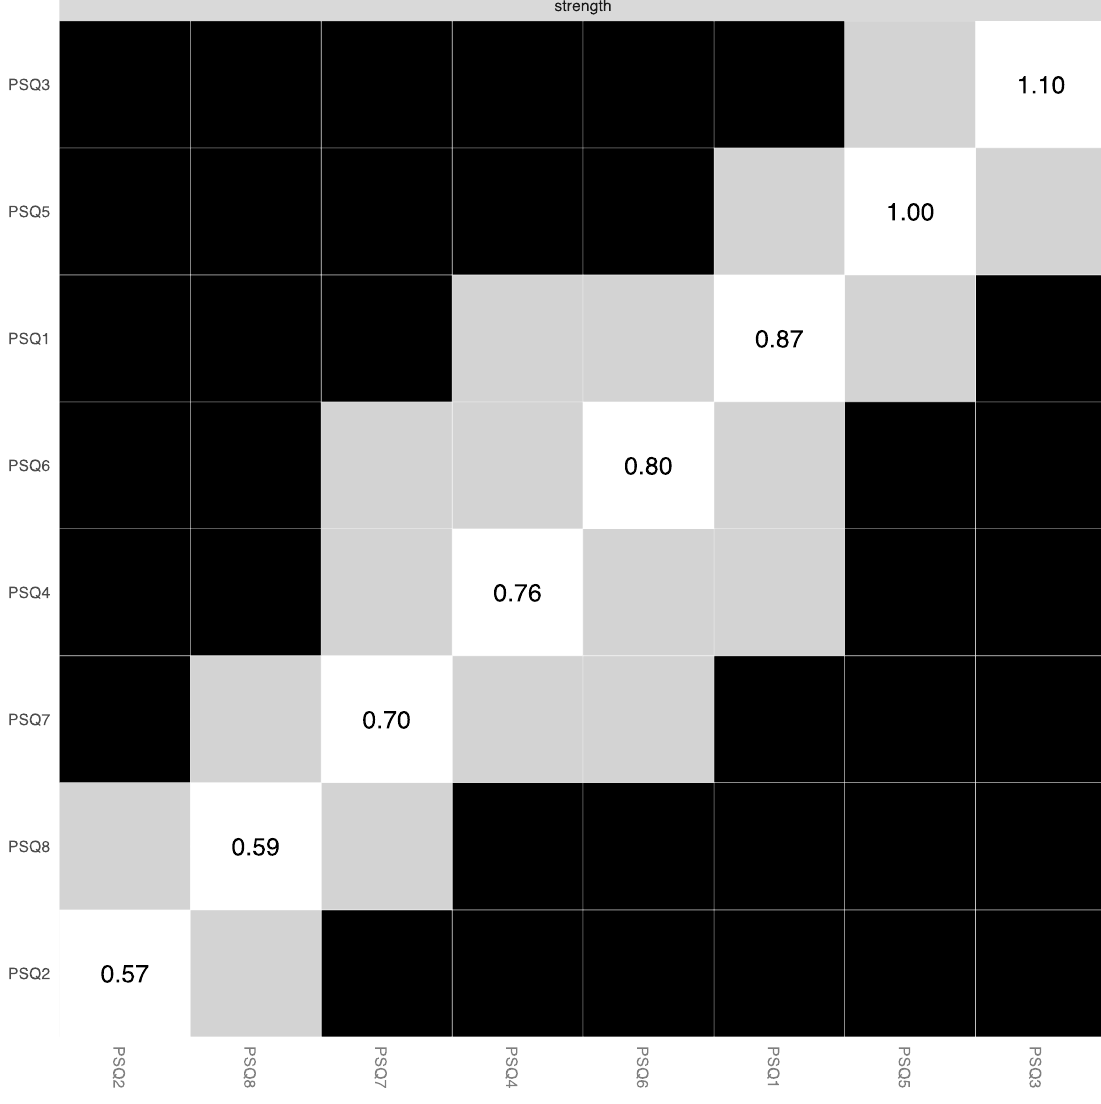
Figure 6. Bootstrapped centrality difference test. Note: This tests the bootstrapped significance of centrality estimates for each pairwise node comparison in the global PSQ network ( α = 0.05). Significant differences are depicted by black boxes and non-significant differences by grey boxes, while the diagonal boxes refer to the node strength